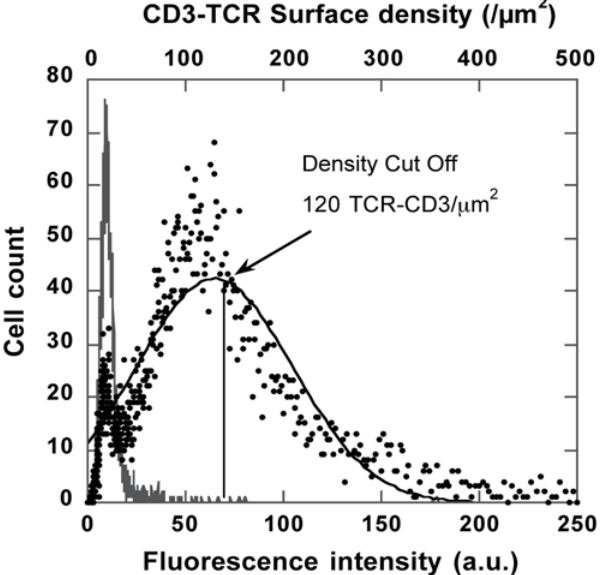
Figure 4. Calcium signal triggered by anti-CD3 particle binding. T cells loaded with the 0.5 m M Fluo-3 calcium probe were Figure 3. TCR/CD3 distribution. Cells (2 6 10 6 /ml) were labelled at placed in contact with anti-CD3 grafted particles ( r L =1.9 6 10 4 / m m 2 ). 25 u C or 37 u C for 30 min using 5 nM FITC-anti-CD3 ( N ) or FITC-anti-CD19 The intracellular calcium concentration [Ca 2 + i ] was obtained from FL1 as a negative control ( — ) in PBS buffer. Cell receptor distribution, fluorescence intensity (see Materials and methods) for particle-bearing reported by fluorescence intensity in channel 1 (FL1) shows a fraction of cells ( m ) and free cells ( N ) identified by their respective FL3 intensity. This unlabelled cells of about 25%. Labelled cell distribution was adjusted to is a representative experiment out of more than four. Gaussian distribution ( y ~ 1 p e { x { x ð Þ 2 = 2 s 2 ) (solid black line). Vertical s ffiffiffiffi 2 p line marks the limit for the 30% highest fluorescence right wing of the distribution.